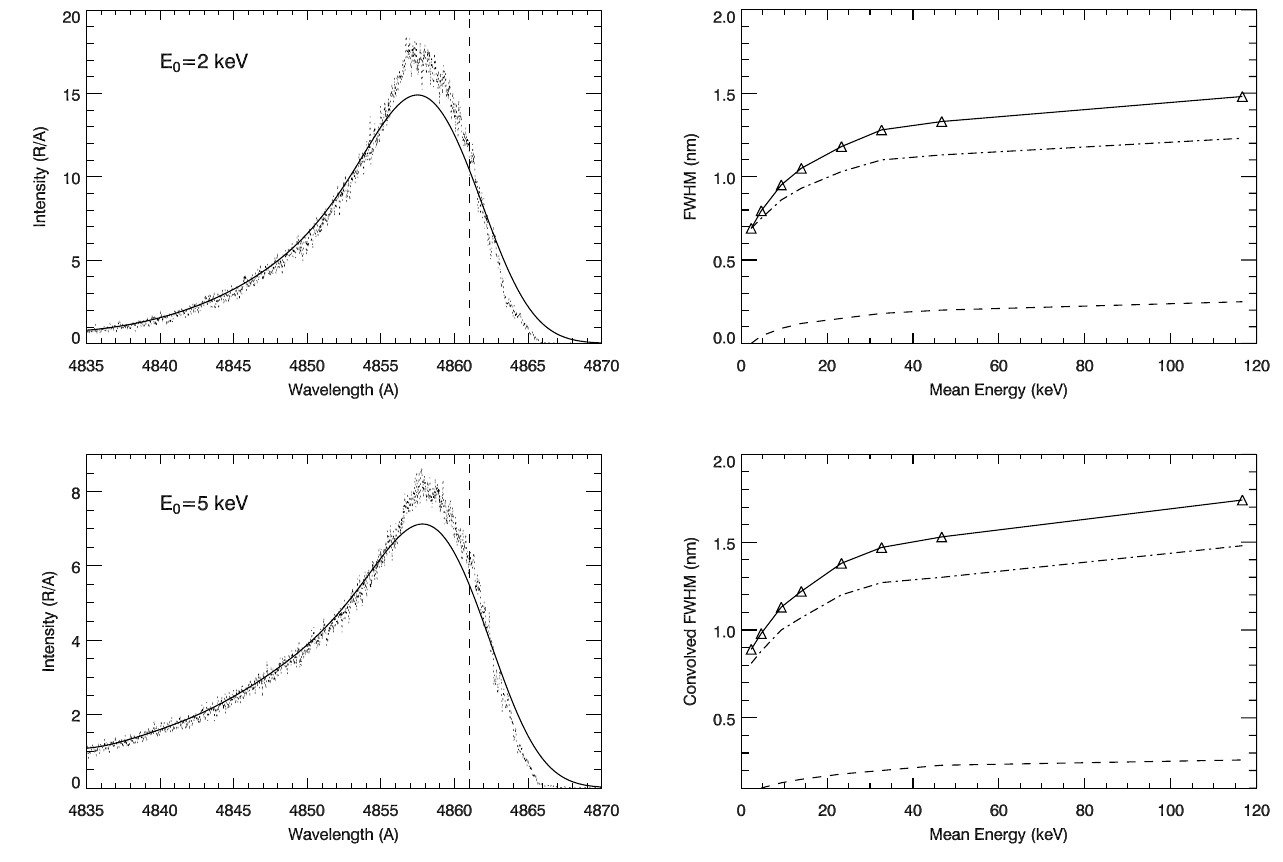
Fig. 3. Dependence of full width at half maximum for simulated (top panel) and convolved (bottom panel) synthetic H- β line profiles on the mean energy of precipitating protons. The dash-dotted lines show the FWHM of the blue wing, and the dashed lines give the FWHM of the red wing.